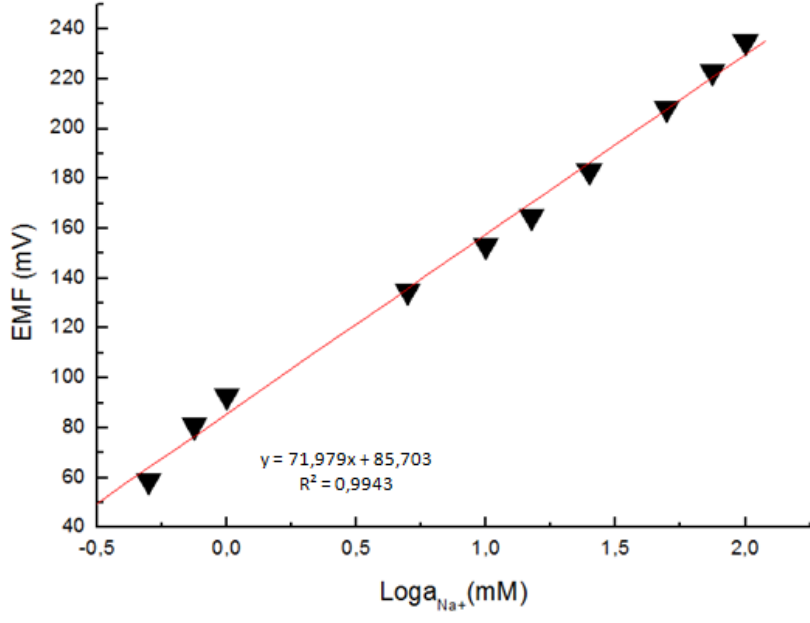
Figure 4. A calibration curve showing the electrochemical potential difference between the Na + -selective ZnO nanorod and the Ag/AgCl reference microelectrodes versus the Na +